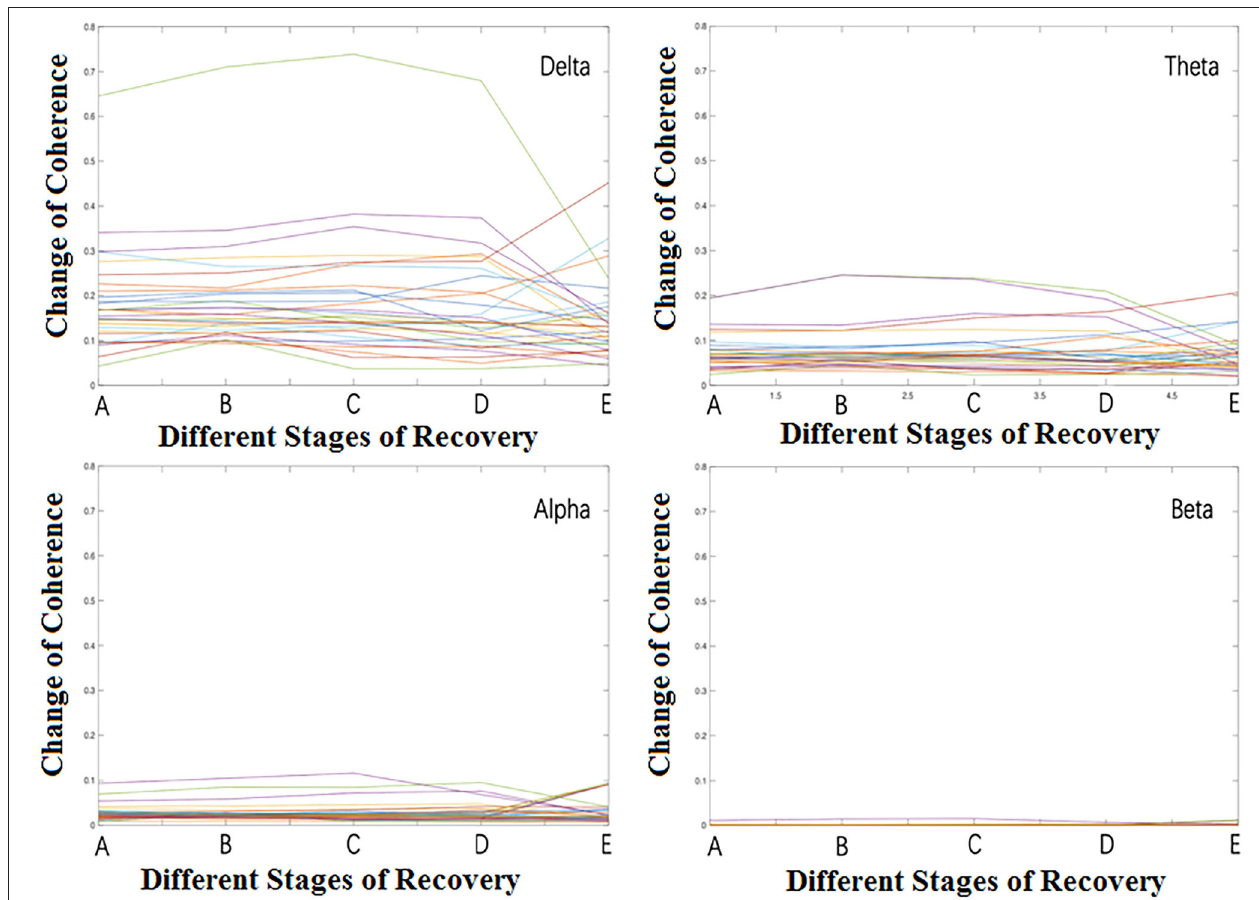
FIGURE 5 | The overall change of coherence among different regions.